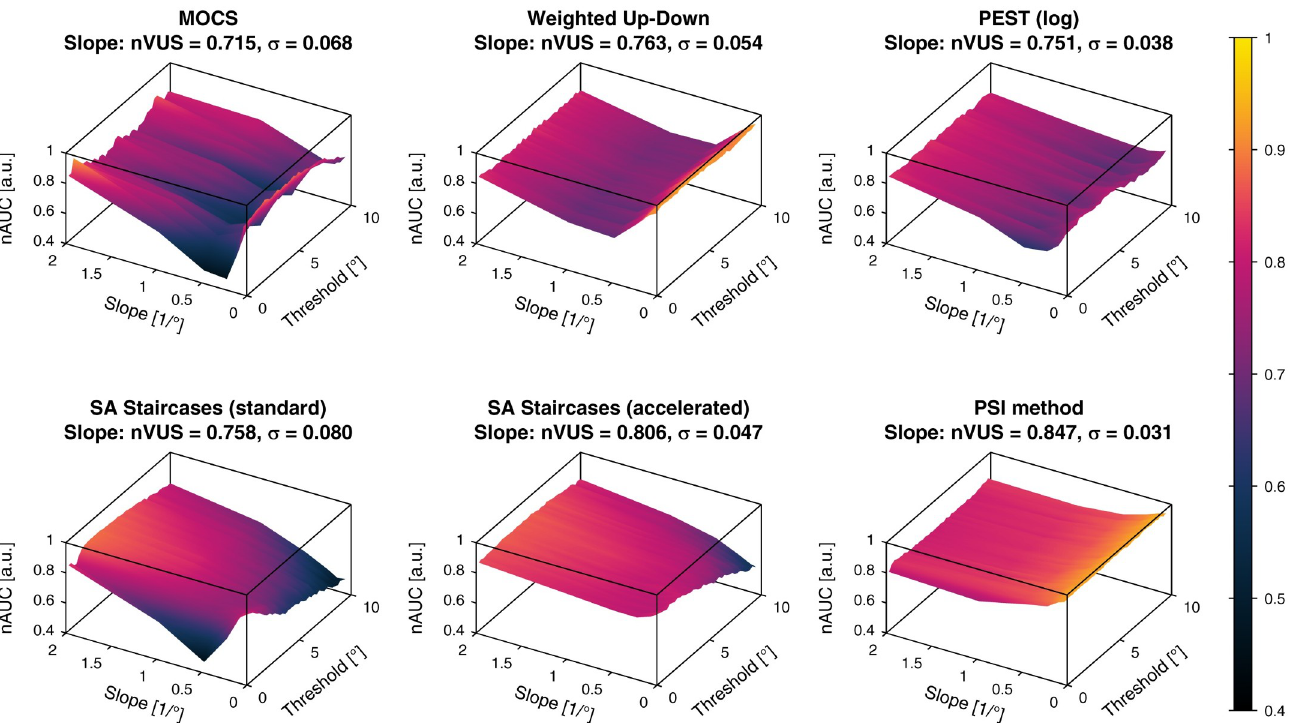
Fig 15. Normalized area under the curve for the slope estimates. The normalized area under the curve ( nAUC , represented by surfaces for the parameter space) and corresponding normalized volume under the surface ( nVUS ) and inhomogeneity parameter σ are shown for the slope estimation. nAUC and nVUS values of 1 correspond to a perfect slope estimation. The color bar indicates the nAUC values in (a.u.).